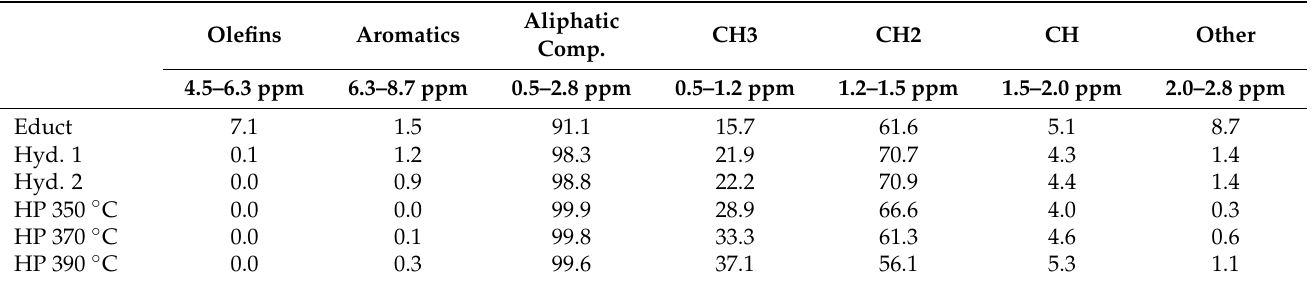
Figure 16. 1 H-NMR spectra of PW middle distillates after hydrogenation and hydroprocessing (note the difference in y -axis scaling for the HP experiments on the right side). Table 5. Composition of pyrolysis wax middle distillates from 1 H-NMR after hydroprocessing, given in area percentage.